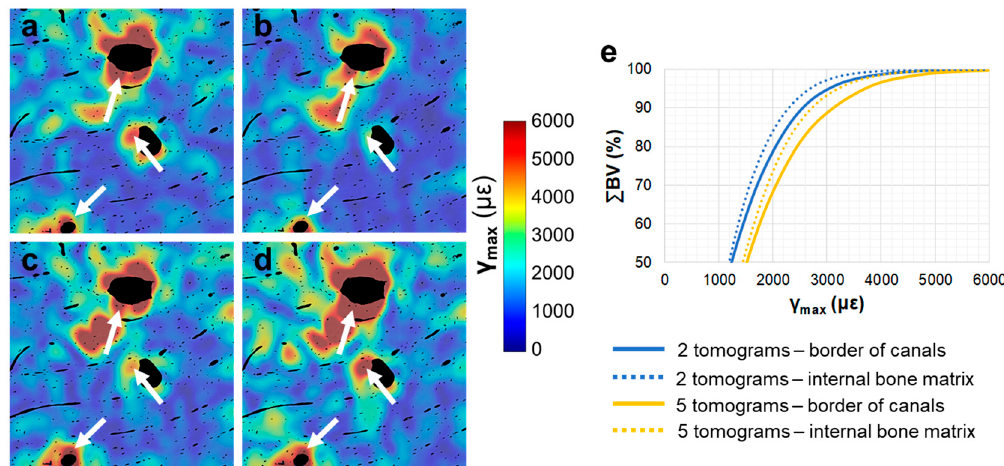
Figure 4. Maximum shear strain ( γ max ) distribution in compact bone tissue imaged at room temperature. Cross-sections in 2D are shown after ( a ) two, ( b ) three, ( c ) four and ( d ) five acquired tomograms. Arrows indicate highly strained regions. A cumulative histogram of the residual strain ( e ) in the tissue voxels around the canals (solid lines) and the remaining bone matrix (dotted lines) is shown for after two and five tomograms.